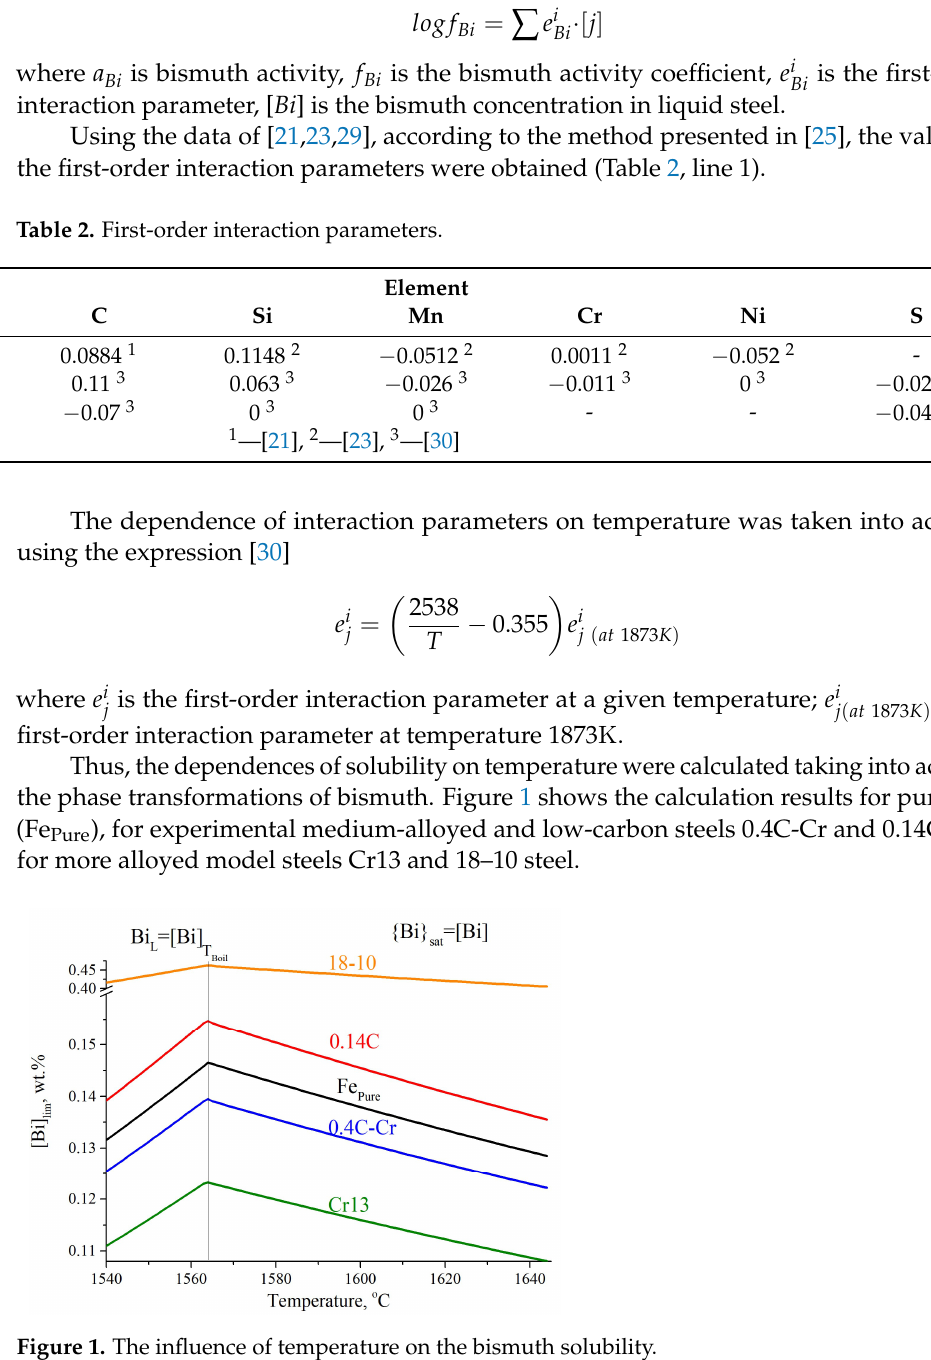
Figure 1. The influence of temperature on the bismuth solubility.